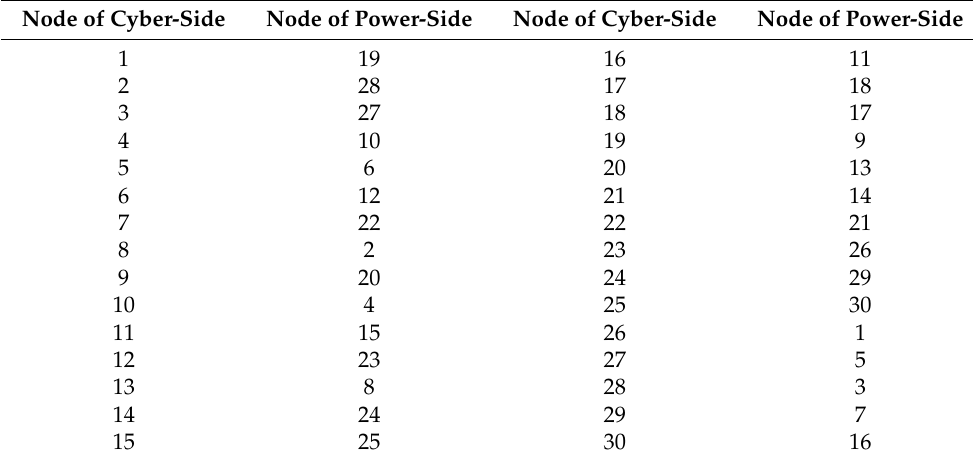
Table 3. Cyber-physical node coupling relationship. Node of Cyber-Side Node of Power-Side Node of Cyber-Side Node of Power-Side 1